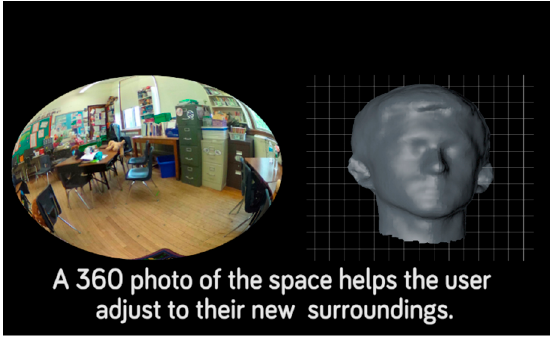
Figure 4. Transition Master Module. Spherical, immersive images can readily be taken of a new place such as a new classroom, or stressful environments such as a crowded or noisy mall or restaurant. These images are displayed by the Empowered Brain headset, offering the user exposure to an unfamiliar setting or context and the ability to practice navigating the environment before visiting it in person.